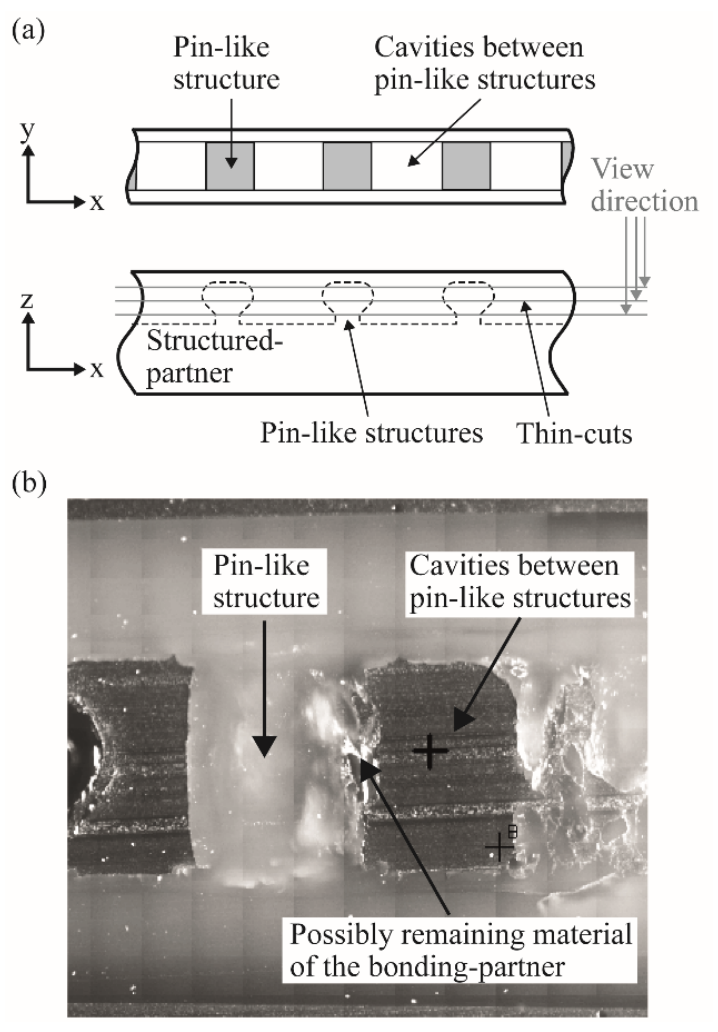
Figure 4. Method for characterization of material residues at the structured-partner after thermal separation using FTIR: ( a ) schematic illustration of sample preparation, ( b ) prepared thin-cut for FTIR analysis.